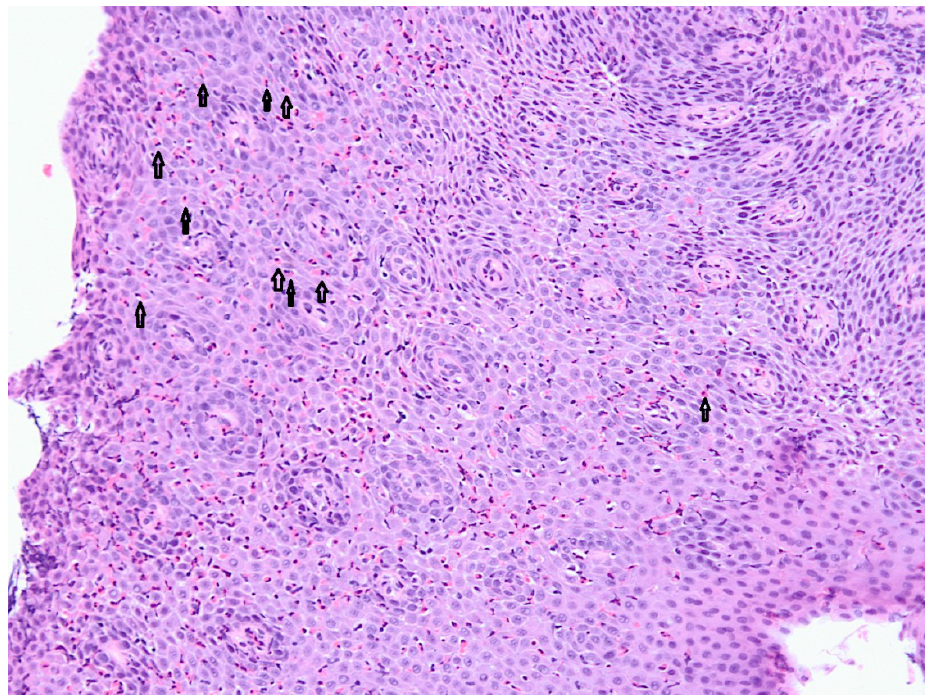
Figure 1. Classic histological findings of eosinophilic esophagitis: hypereosinophilia, usually with >15–20 eosinophils per high-powered field. Eosinophils in the squamous mucosa